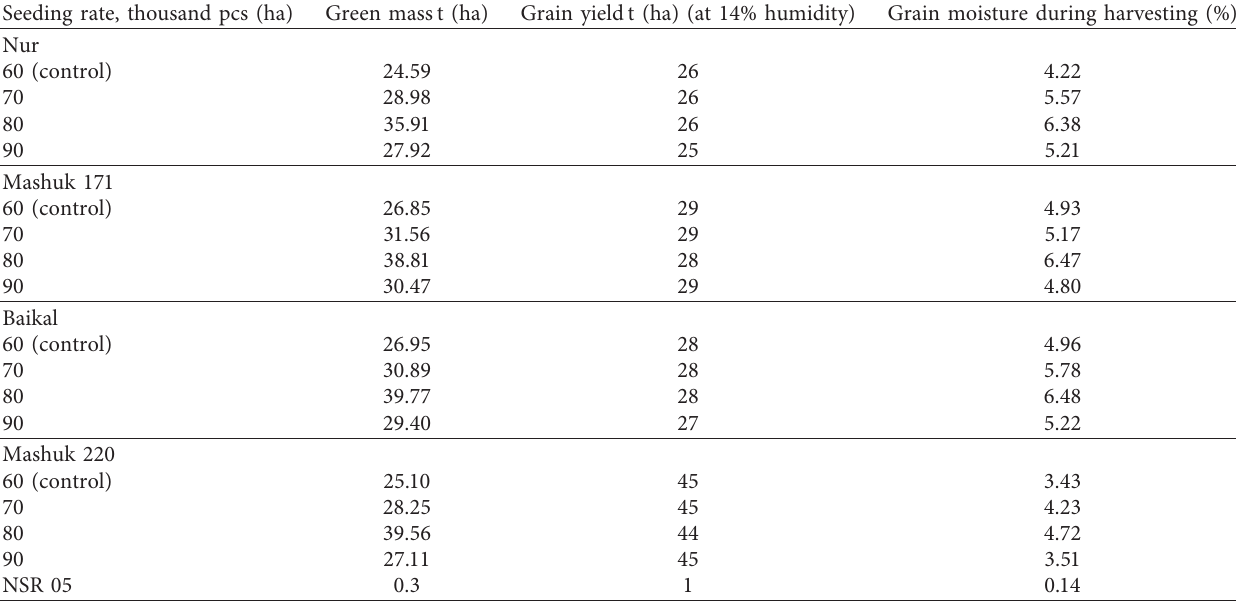
Table 3: The yield of green mass and grain of maize hybrids depending on the seeding rate.